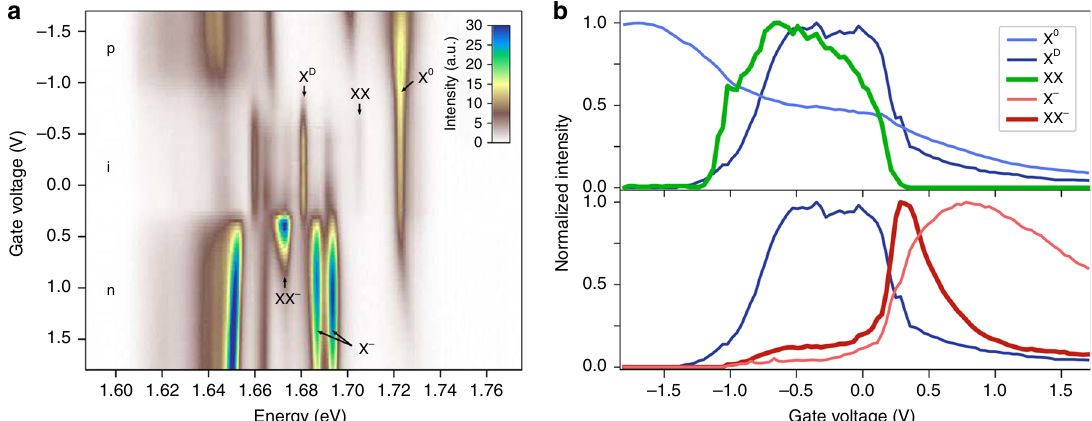
Fig. 3 Doping dependence of the PL emission of neutral and charged biexcitons. a Gate dependence map of the PL intensity above the onset for observing both biexciton species ( I 0 = 4 × 10 3 W cm − 2 ). The intrinsic regime is characterized by the strong emission from X D . In the n-doped and p-doped regimes, trions and other species emerge. The XX peak at 1.703 eV is only observed in the intrinsic regime, indicating a neutral biexciton composed of a neutral X 0 and X D . Another peak with superlinear power dependence is observed at 1.671 eV, 52 meV below X 0 . It is assigned to a charged biexciton state, as it appears only in the low n-doped regime. b Normalized PL intensity of the exciton species relevant for the formation of biexcitons as a function of doping level. The neutral biexciton (green) emission is limited to the intrinsic regime, in which X D (dark blue) is observed, showing the important role of X D in the formation of XX. The XX − emission (dark red) is strongest in the low n-doped regime, where X 0 (light blue), X D and the two X − species coexist (light red, only lower X − shown for clarity)